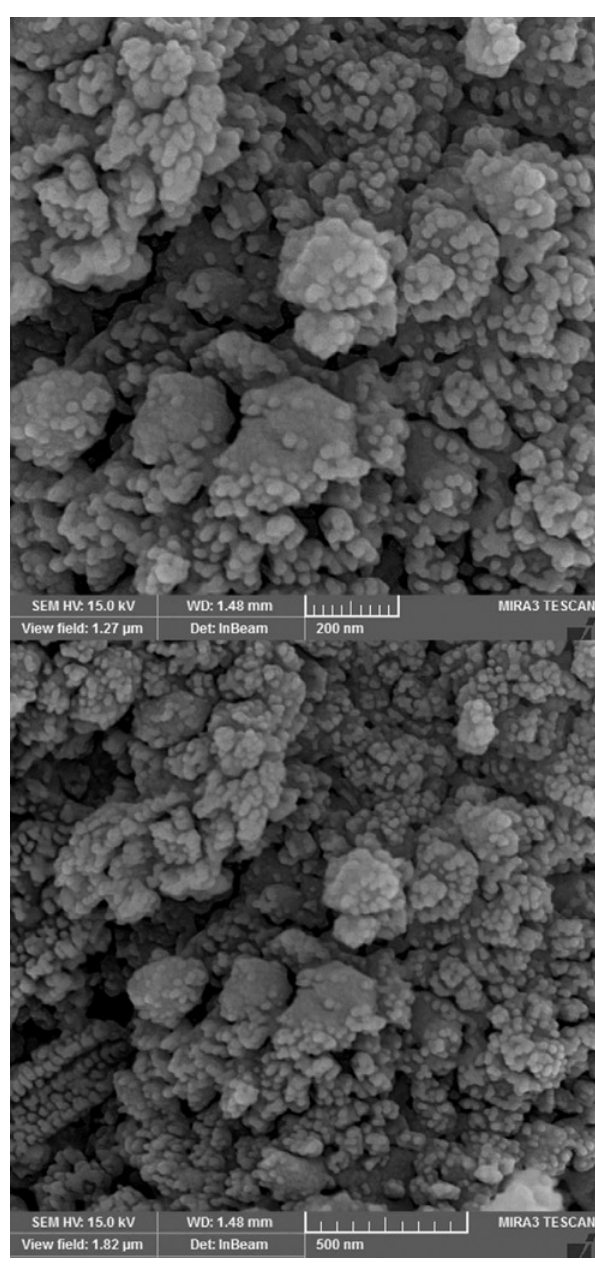
O synthesized at 700 ° 12 19